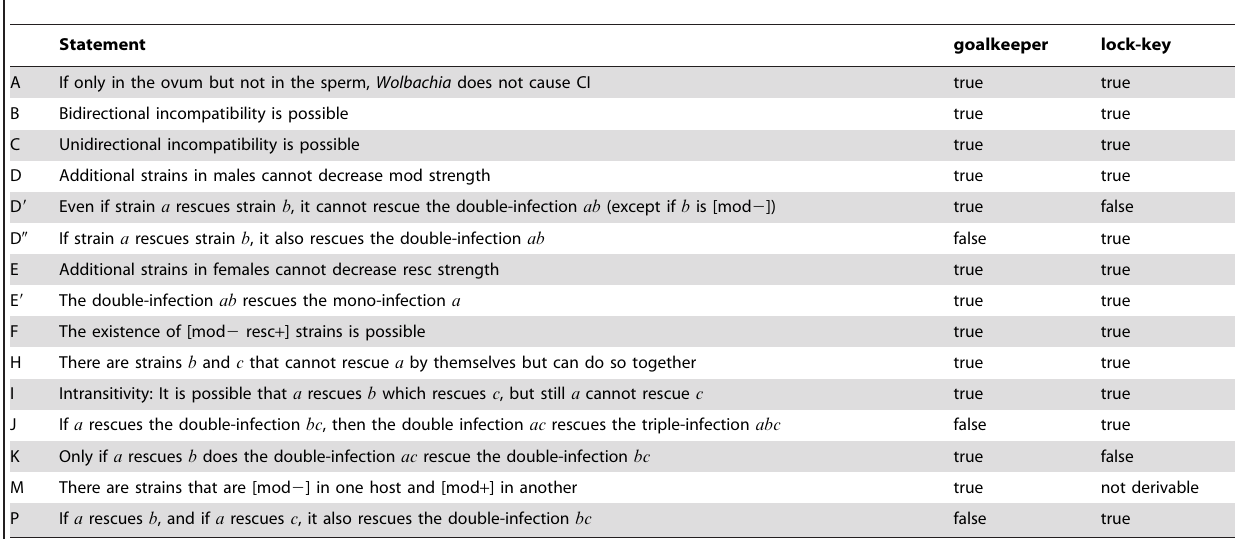
Table 1. The most interesting statements and their truth values according the goalkeeper-model and the lock-key-model.